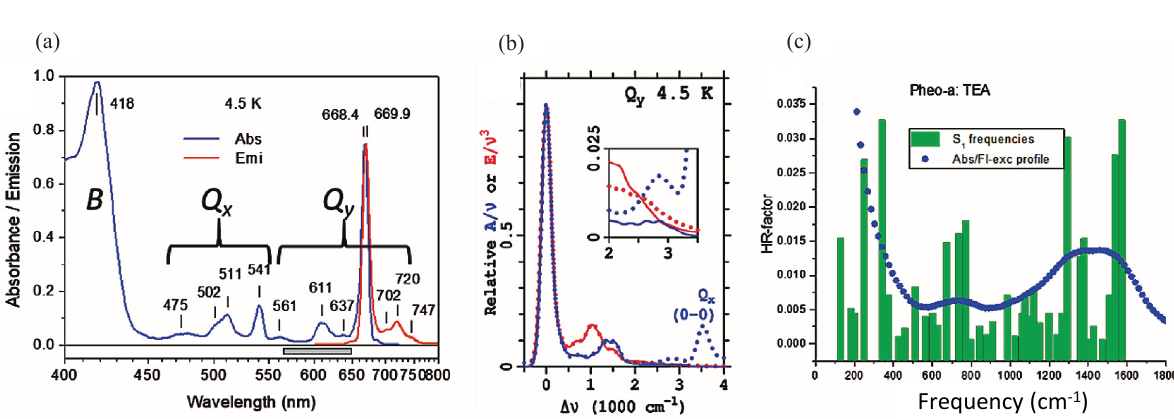
Fig. 4. Aspects of the absorption and emission spectra of Pheo-a in TEA glass at 4.5 K. (a) Unscaled low-resolution spectra, discernible in contributions from the Soret bands B as well as from the Q and Q bands. (b) The Q spectra shown as deviations Δ 𝜈 = 𝜈 − 𝜈 in x y y 00 absorption ( A ) and 𝜈 − 𝜈 in emission ( E ), normalized to produce the band-shape functions 𝐴 / 𝜈 and 𝐸 / 𝜈 3 (dots), and their fit to a 00 Huang − Rhys model (solid lines). (c) Absorption-type spectra as prepared for (b), except that the band-shape function is quantified as an effective Huang − Rhys factor (this is accurate only if bands are non-overlapping) depicting low-resolution and high-resolution fluorescence excitation spectra. Adapted with permission from [122]. Copyright 2019 AIP